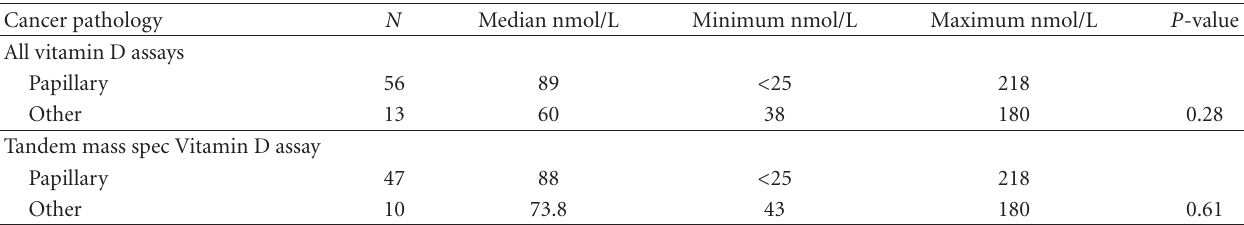
Table 4: Histologic Type of Thyroid Cancer and 25-OH-D